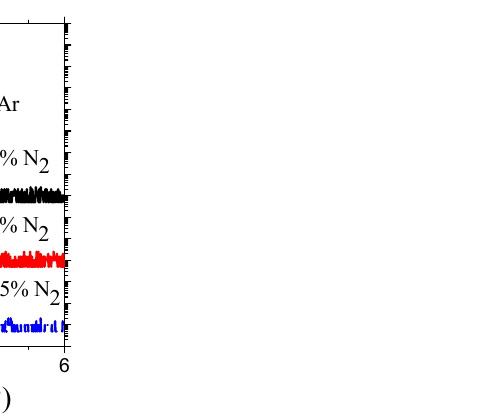
Figure 1. Measured GIXRR curves for the Ni/C multilayers fabricated with pure Ar and nitrogen- argon gas mixture.